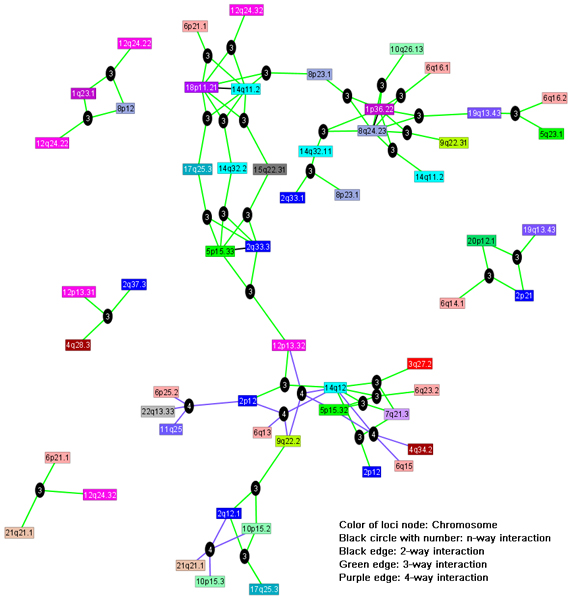
Genome-wide association network for rheumatoid arthritis. A different color represents each chromosome.